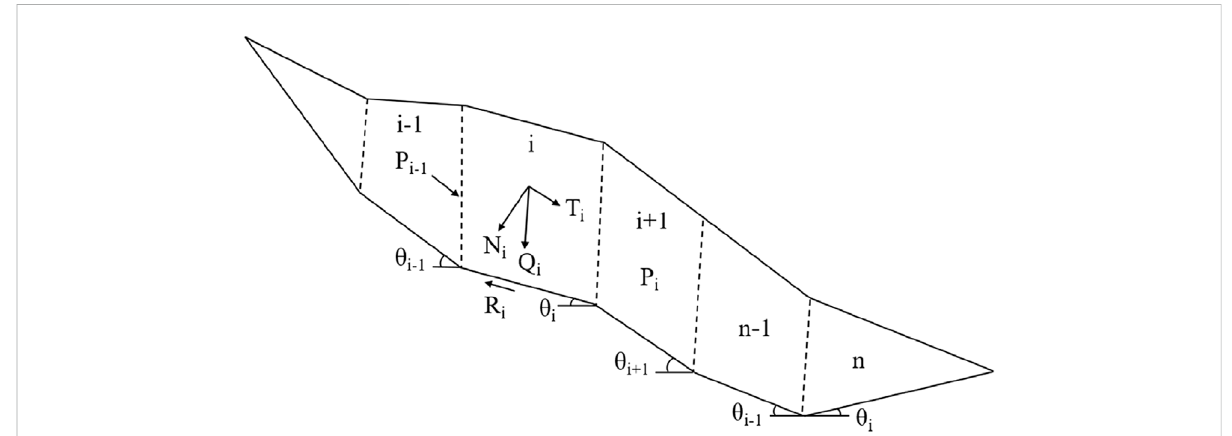
FIGURE 7 Schematicdiagramoftheimplicitsolutioncalculationmodelofthetransfercoef fi cientmethodforslopewithbrokenlineslidingsurface(Inthis paper, thelandslide 1 – 1 ′ section is divided into nine blocks for overall stability calculation, and the stability of two possible secondary shear outlets is also calculated) (Baker et al., 1980; Hutchinson et al., 1982).